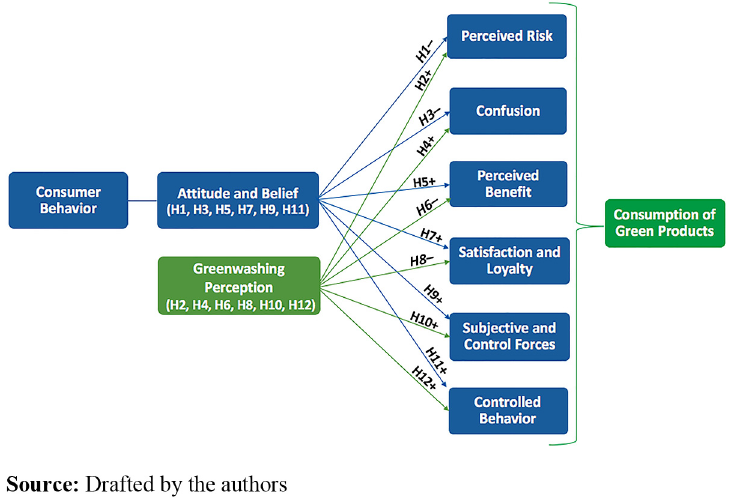
Figure 1. Proposed theoretical